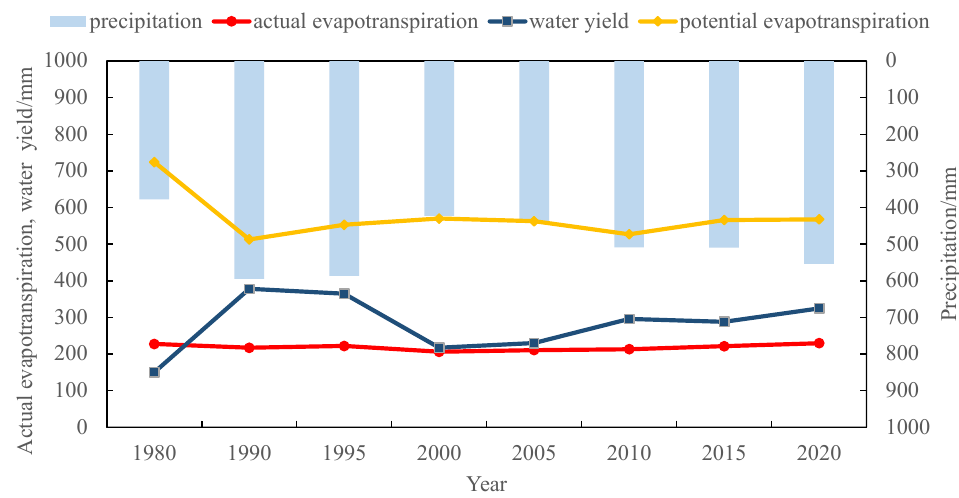
Figure 6. Annual precipitation, actual evapotranspiration, water yield, and potential evapotranspiration in the eight years during 1980–2020.